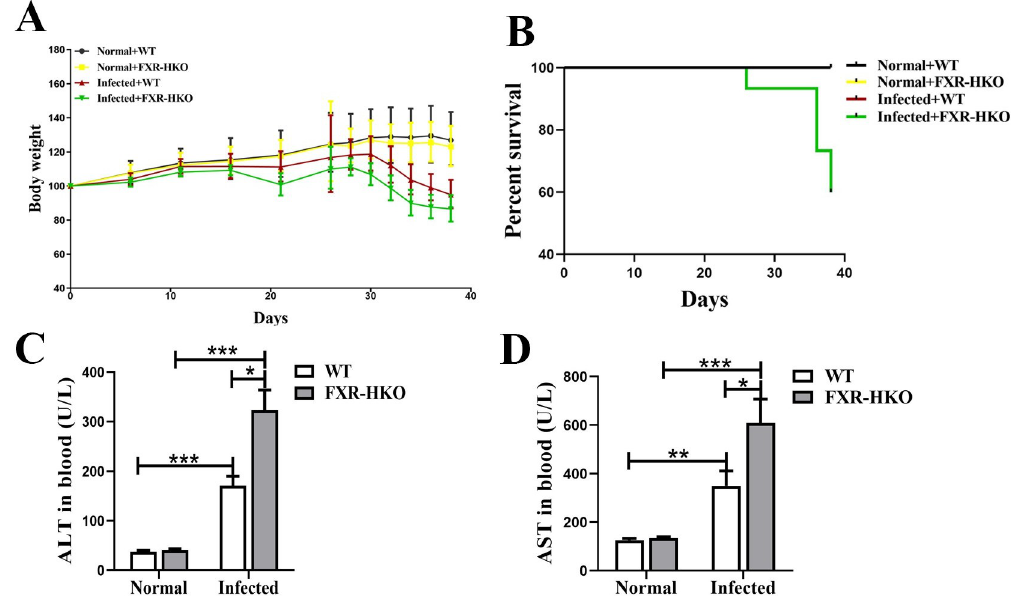
Fig 2. FXR deficiency promotes the loss of body weight, death of mice, and liver injury caused by S . japonicum infection. (A) The change ratio of body weight for mice in each group. (B) Survival rate of each group. (C) Serum analysis of ALT for mice in each group. (D) Serum analysis of AST for mice in each group. Data are presented as mean ± SEM. � P < 0.05, �� P < 0.01, ��� P <